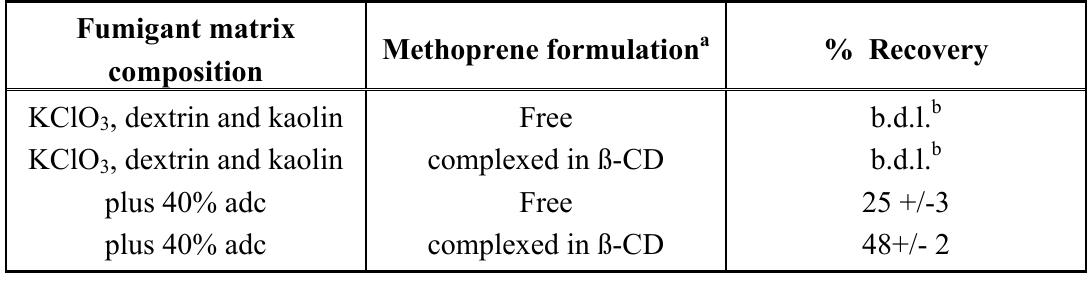
Table 3. Methoprene recovery in fumes of different starting fumigant